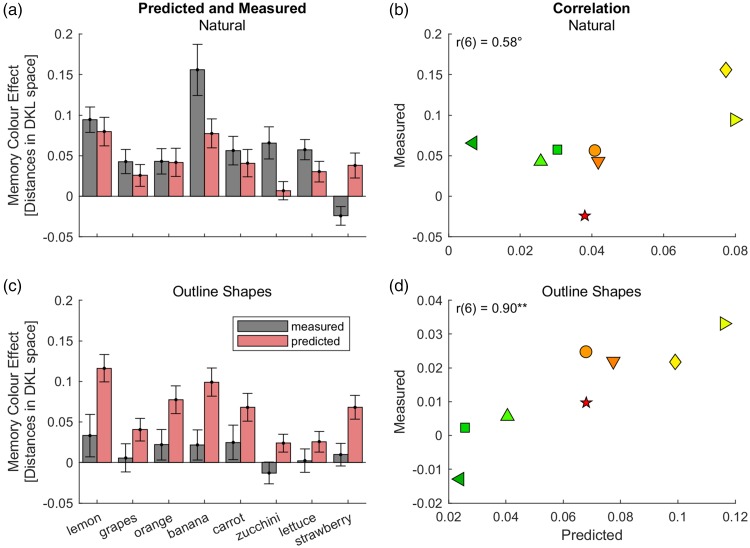
Predictions for aggregated data of Experiment 1a of Olkkonen et al. (2008). The upper row ((a) and (b)) illustrates results for photographs, the lower row ((c) and (d)) those for the outline shapes. The grey bars correspond to the bars in Figure 4(a) of Olkkonen et al. (2008). Note, however, that the bars in this figure show absolute shifts of grey adjustments in the opposite direction of typical adjustments, the Memory colour Indices shown in Olkkonen et al. (2008) represent relative shifts, that is, the absolute shifts relative to the typical adjustments. **p < .01; °p < .1.